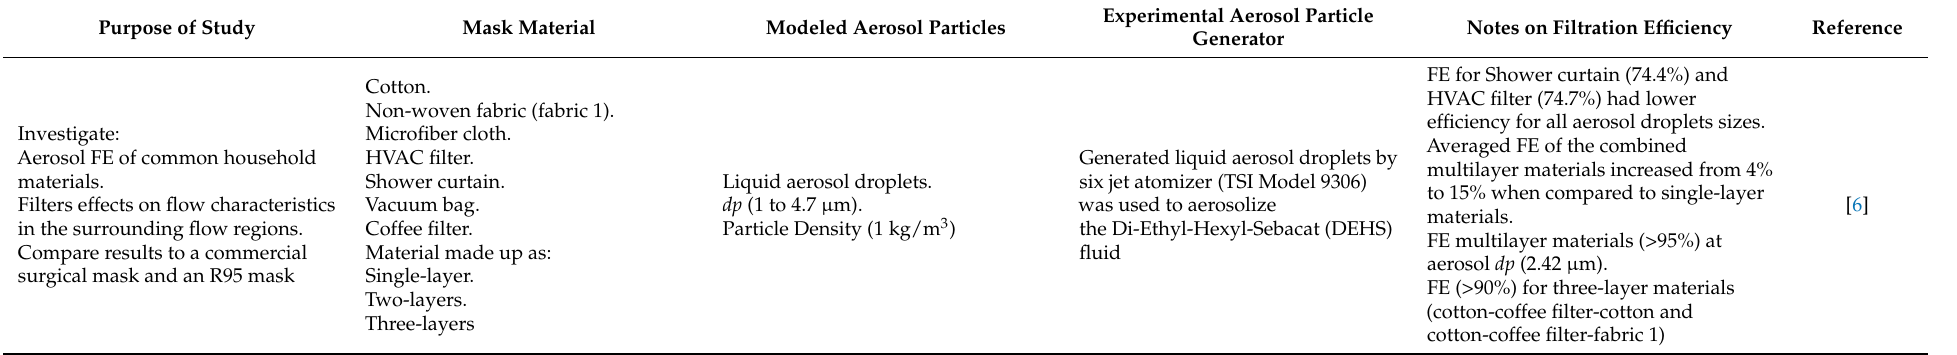
Table 6. Summary of face mask and respirator filtration experiments and testing practices using liquid